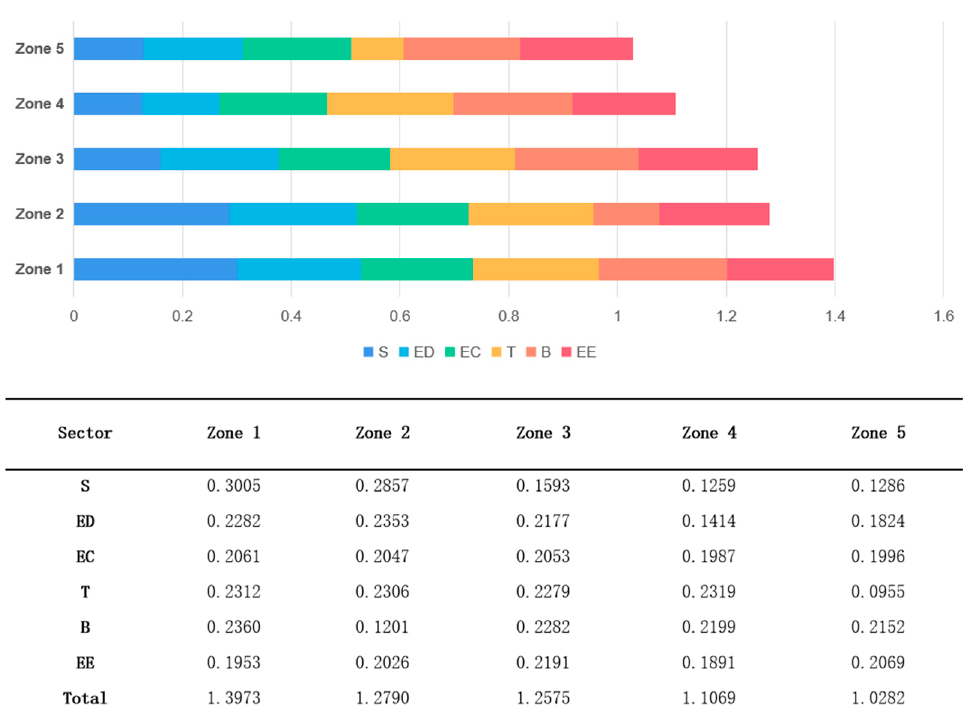
Figure 3. Values and total values for each sector of the 5 zones.